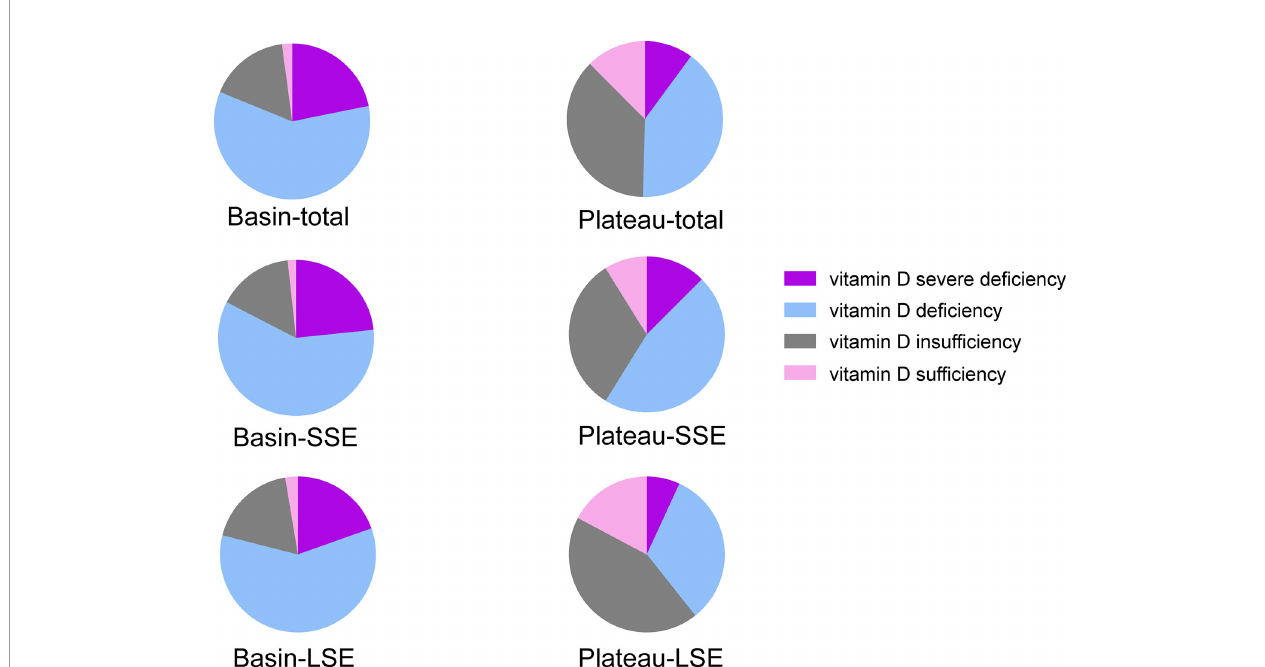
FIGURE 2 | Distribution of 25(OH)D categorized by region and sunlight exposure. Total, total participants in this region; SSE, short sunlight exposure, <3 hours daily; LSE, long sunlight exposure, ≥ 3 hours daily.